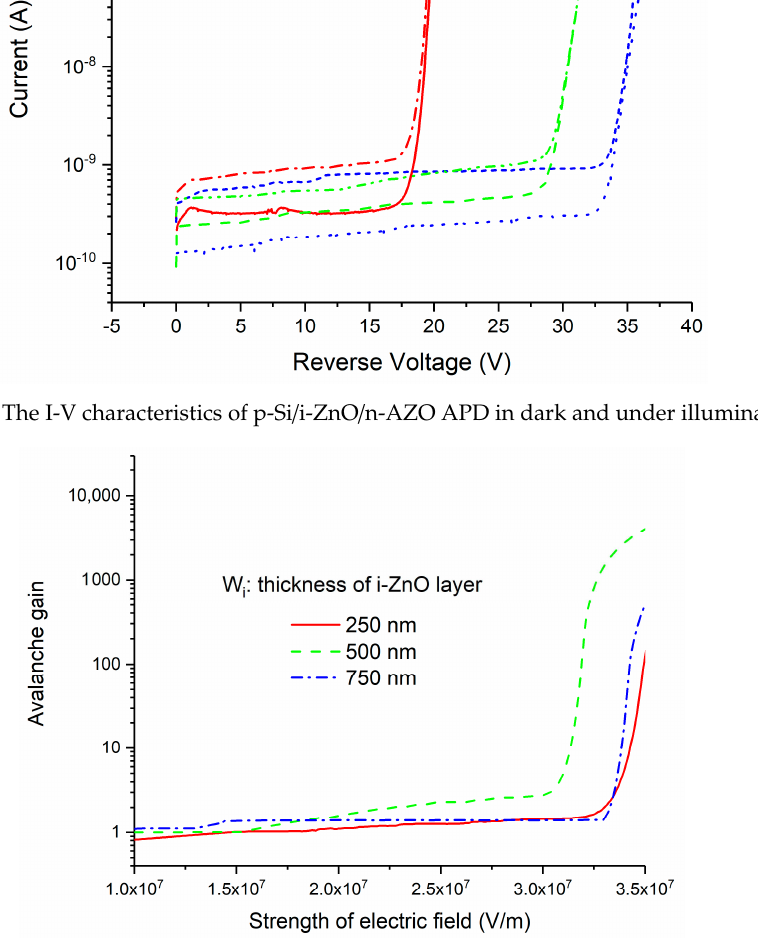
Figure 14. The avalanche gain at various reverse voltages.